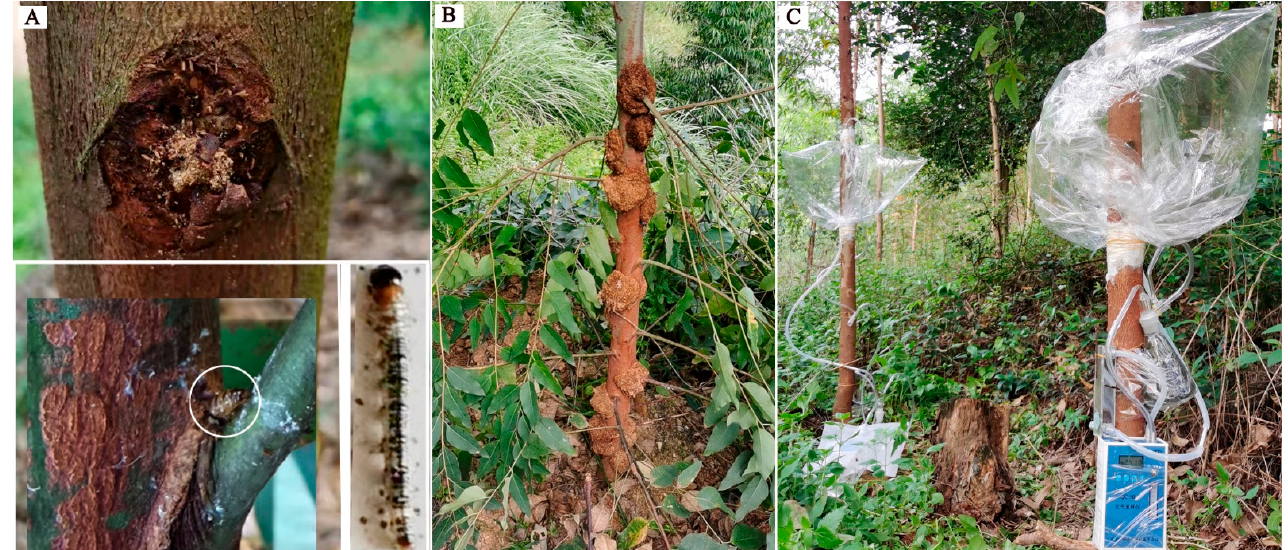
Figure 1. Larval entrance cover packet and worm holes of 3rd instar larvae transferred to eucalyptus trunks (circle shows the caudal spine) ( A ), aggregation infestations of E. signifer ( B ), and collection of eucalyptus volatiles ( C ).